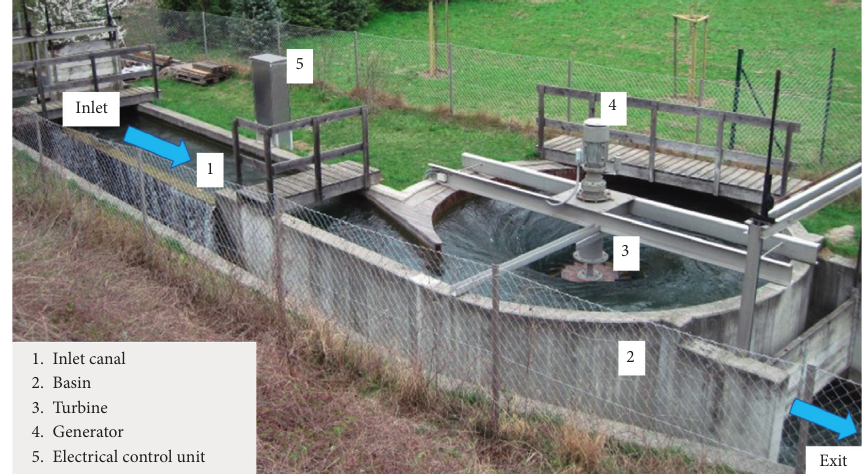
Figure 1: Basic components in a GWVPP—installation at Obergrafendorf, Austria (reproduced with permission from